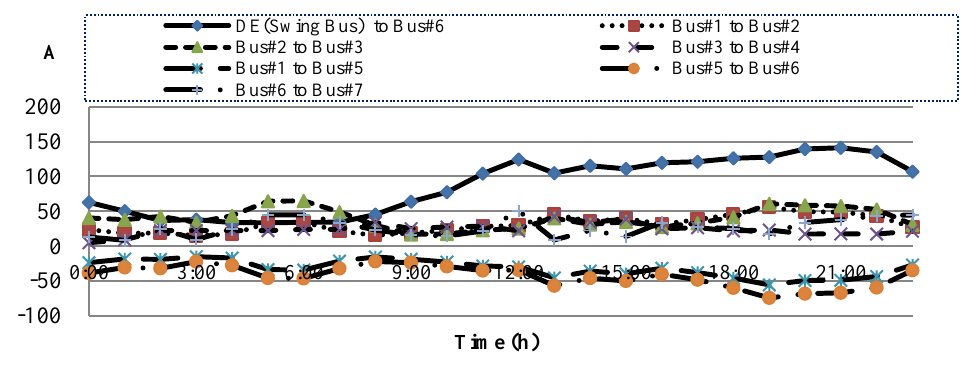
Figure 14. Numerical results of current flow under autonomous operation.